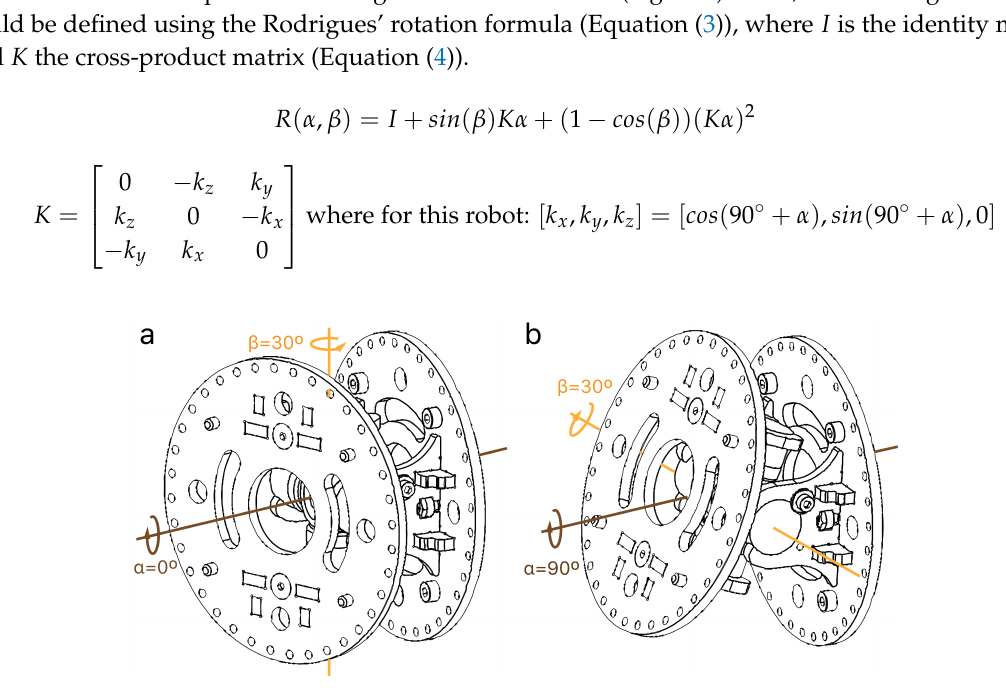
Figure 9. The robot is comprised by universal joints, each one with 2 degrees of freedom. The rotations are defined by two angles α and β which do not directly represent the rotation axes, but the direction and the magnitude of the rotation, respectively. ( a ) Rotation around one axis. ( b ) Rotation around the perpendicular